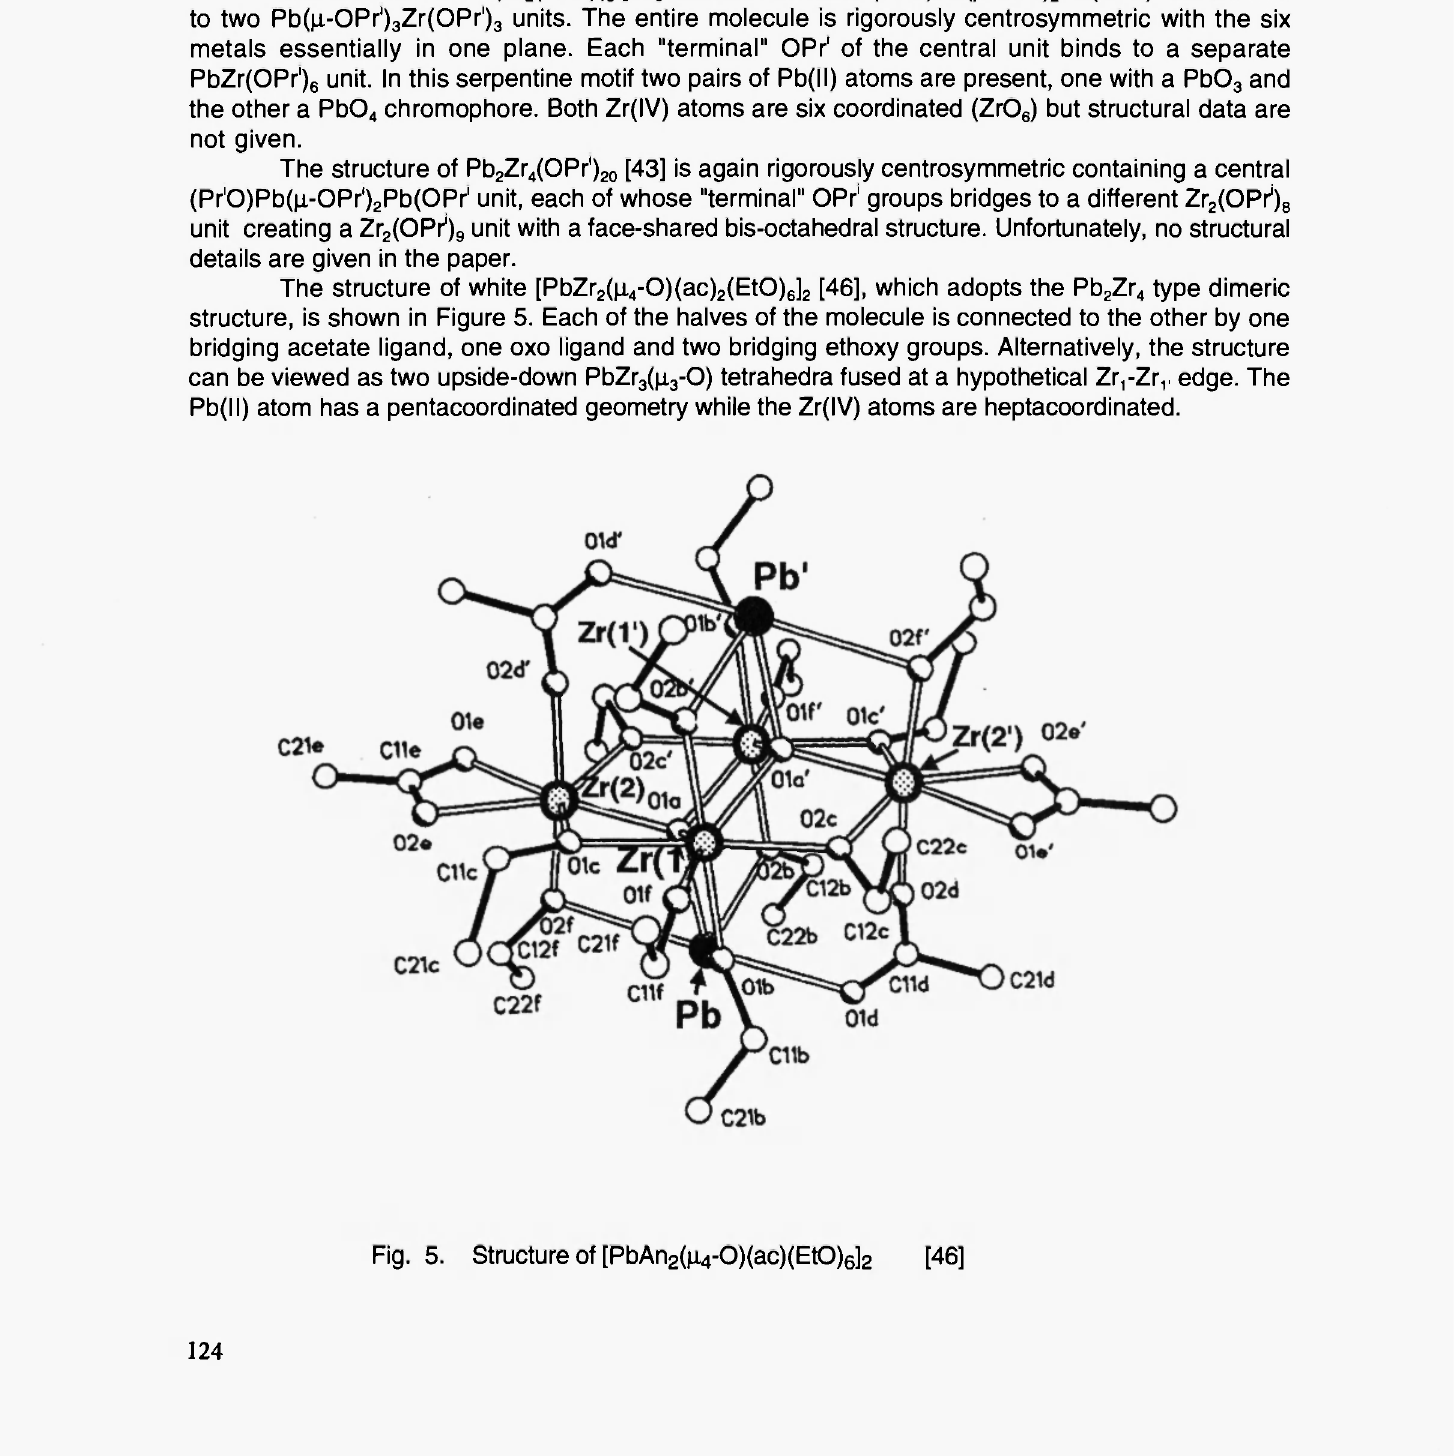
Fig. 5. Structure of [PbAn